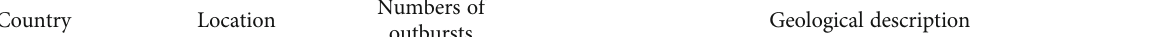
Table 1: Outbursts and their geological information from di ff erent countries [14, 16, 110, 114, 117, 119, 122 – 126]. Country